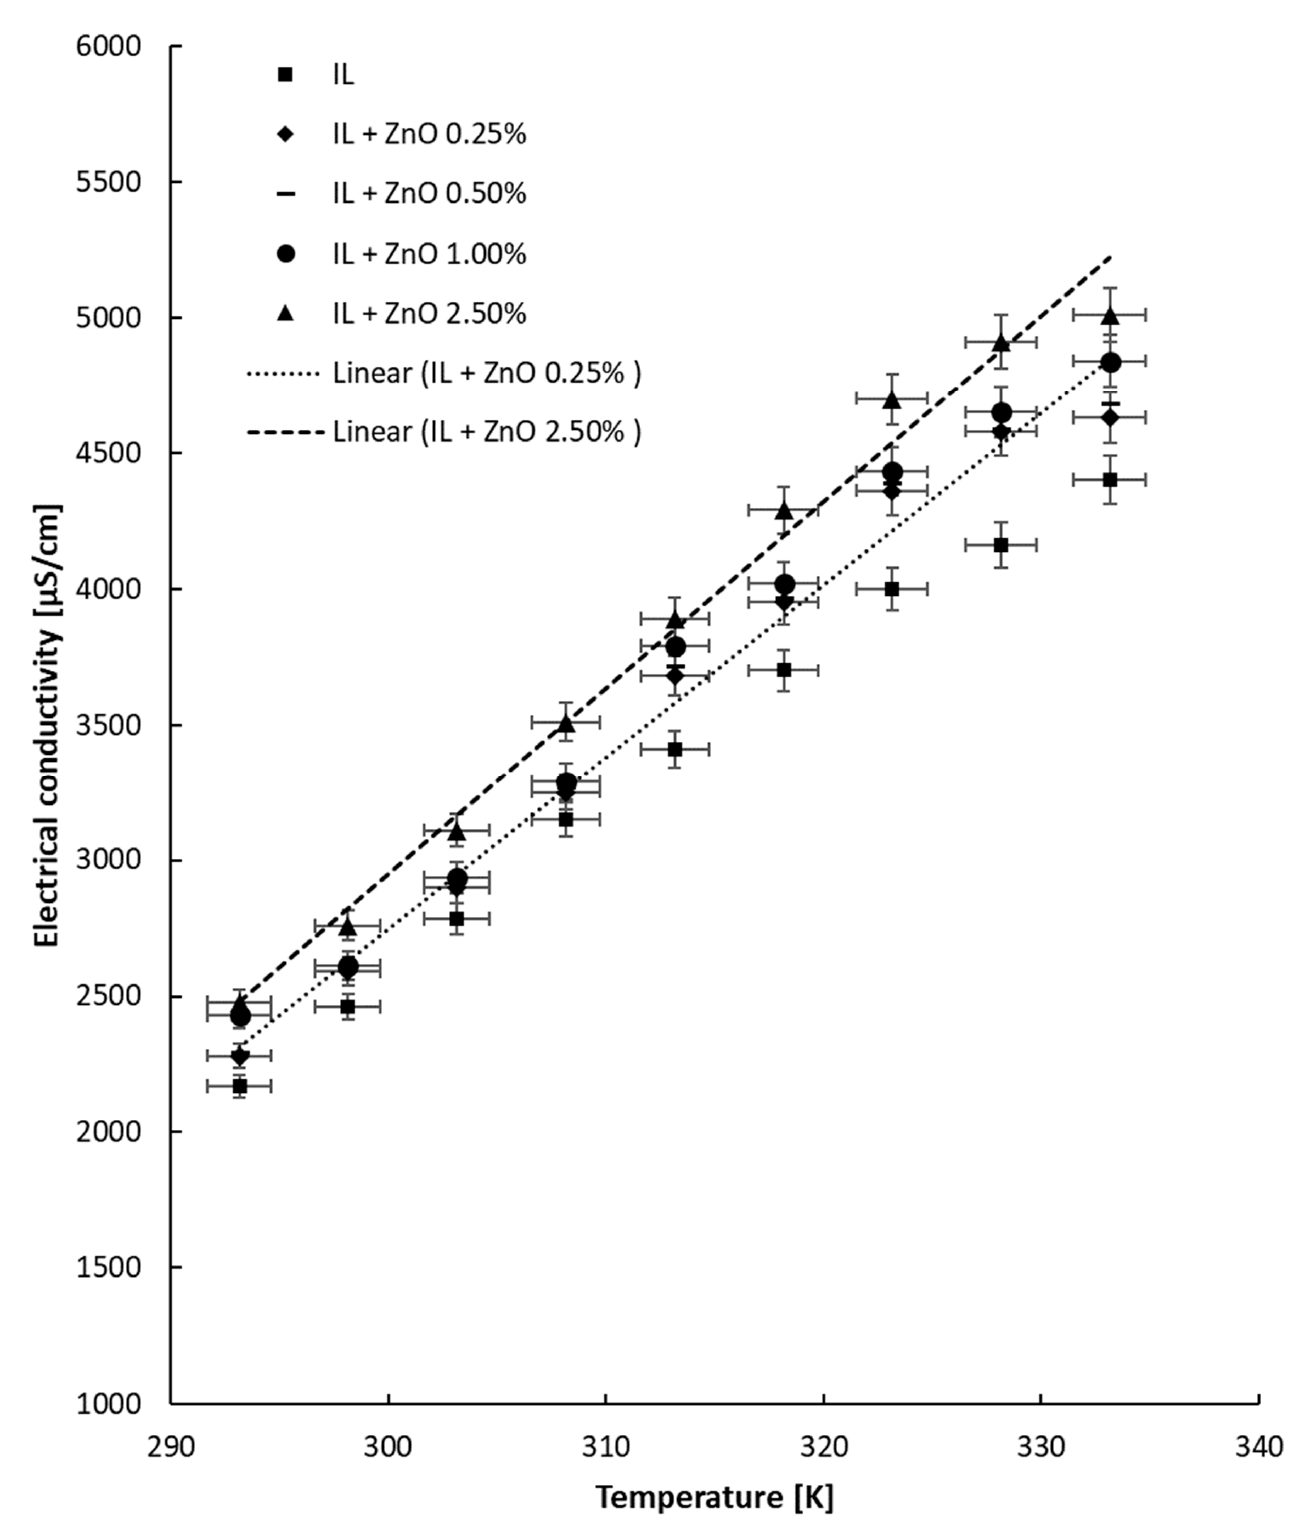
Figure 5. Experimental results for electrical conductivity variation with temperature: ZnO + IL sam- ples.